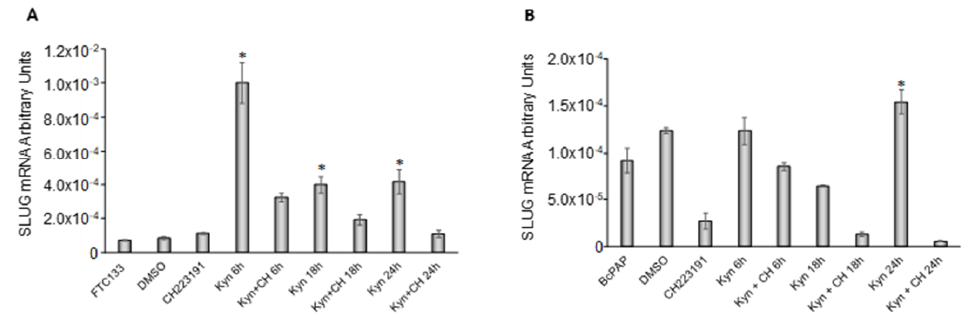
Figure 6. Kynurenine induces SLUG expression. FTC-133 ( A ) and BcPap ( B ) cells were incubated for the indicated times with kynurenine (100 µM) in the presence or absence of the AhR inhibitor CH223191 (10 µM) and harvested for total RNA extraction and cDNA synthesis. SLUG mRNA expression levels were assayed by qPCR. The data are presented as means of arbitrary units. All experiments were repeated three times and the more representative results are depicted. DMSO: Dimethyl sulfoxide treated cells; Kyn: kynurenine treated cells; CH: CH223191 treated cells. p values were calculated applying the unpaired Student’s t test. *, p < 0.05. To confirm at the protein level the effects induced by kynurenine on gene expression, we performed a western blotting analysis in FTC-133 and BcPap cell lines (Figure 7). In FTC-133 cells, treatment with kynurenine induced an increase of IDO1 and SLUG expressions that started at 6 h and lasted for the entire duration of the experiment. On the contrary, co-administration of CH223191 abolished the kynurenine effect. Conversely, AhR was barely detectable in cells treated with kynurenine but administration of CH223191 led to its increase. In BcPap cells, treatment with kynurenine induced a slight increase of SLUG expressions at 6 h but no effect on IDO1 expression. expression was not stimulated by kynurenine treatment but increased by the addiction of CH223191.